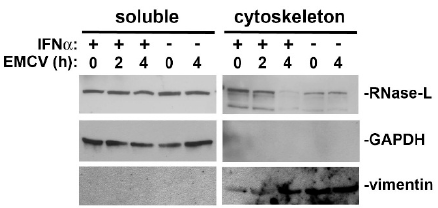
Figure 4. Analysis of RNase-L association with the cytoskeleton. Caco-2 cells were treated with 500 U/mL hIFN α for 24 h and then infected with encephalomyocarditis virus (EMCV; MOI = 10) for 2 and 4 h. Soluble and cytoskeletal protein fractions were collected using the ProteoExtract Cytoskeleton Enrichment and Isolation Kit (Millipore) according to the manufacturer’s protocol. GAPDH and vimentin were used to evaluate soluble and cytoskeleton fraction purity, respectively.